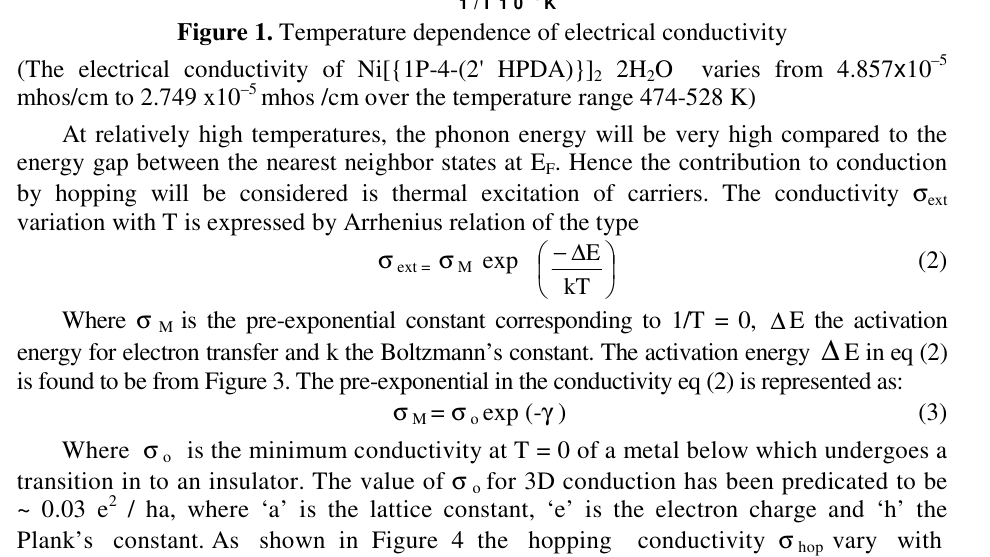
2H O varies from 4.857 x 10 2 2